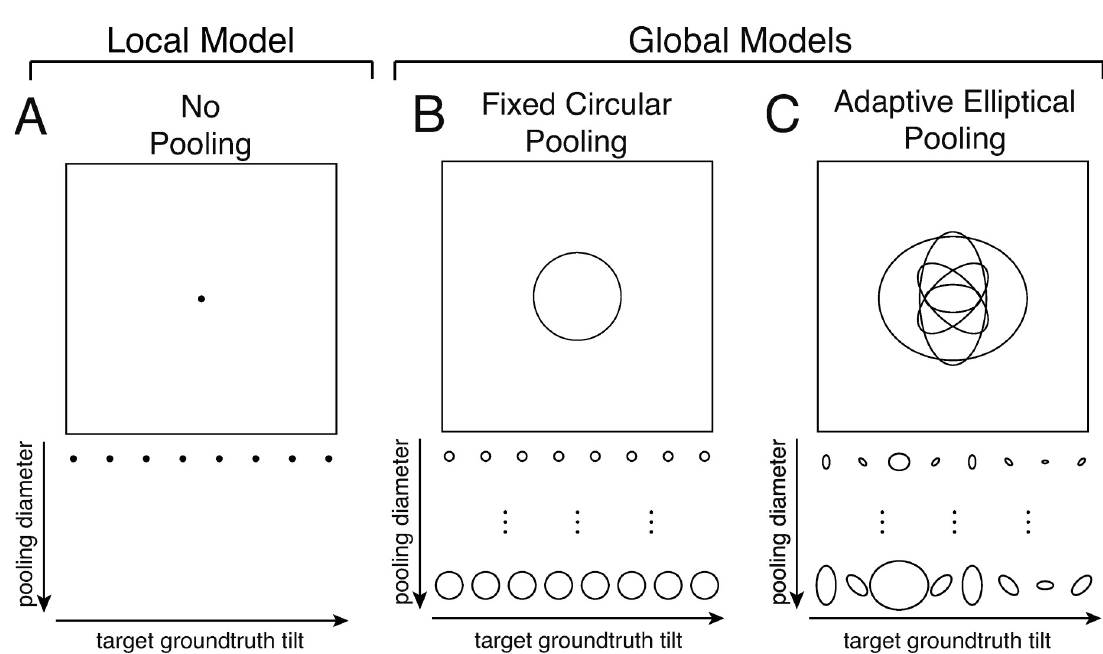
Fig 5. Local and global models for tilt estimation. A The local model obtains a local tilt estimate given three local image cues. B The fixed circular pooling model uses a circular pooling region with the same size for all target groundtruth tilts (cf. Fig 2D). C The adaptive elliptical pooling model uses an adaptive pooling region with a different size, aspect ratio, and orientation for each groundtruth tilt (cf. Fig 2E). As the average area of the adaptive elliptical pooling region changes, the relative area, orientation, and aspect ratio of the pooling regions are held fixed.